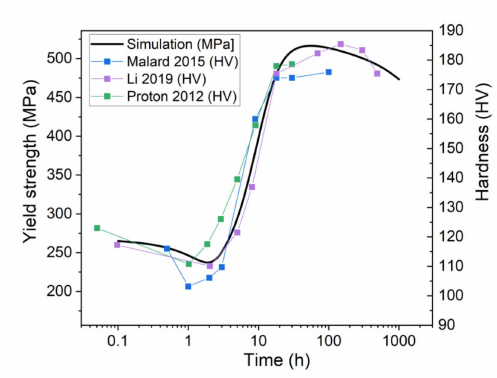
Figure 6. A comparison between the simulation with the original model of Li et al. [9] and mea- surements of Malard et al. [6], Li et al. [9] and Proton et al. [26] for the heat treatment at 155 ◦ C of